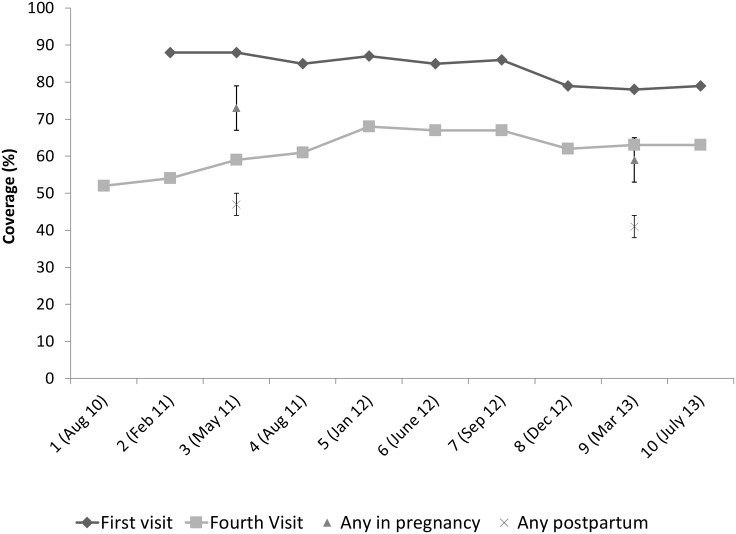
Estimated coverage of volunteer home visits from internal monitoring and household surveys.~ Internal monitoring information (first and fourth visits) refers to information from the volunteers’ workbooks, which were collected throughout the study on a quarterly basis. The number of quarterly review meetings and the median month of data collection are given. * Household survey data include the adequacy survey done in 2011 (based on 257 women with a live birth in the year prior the survey [26]) and the impact evaluation household survey in 2013 (based on 7,823 women with a live birth in the year prior the survey).